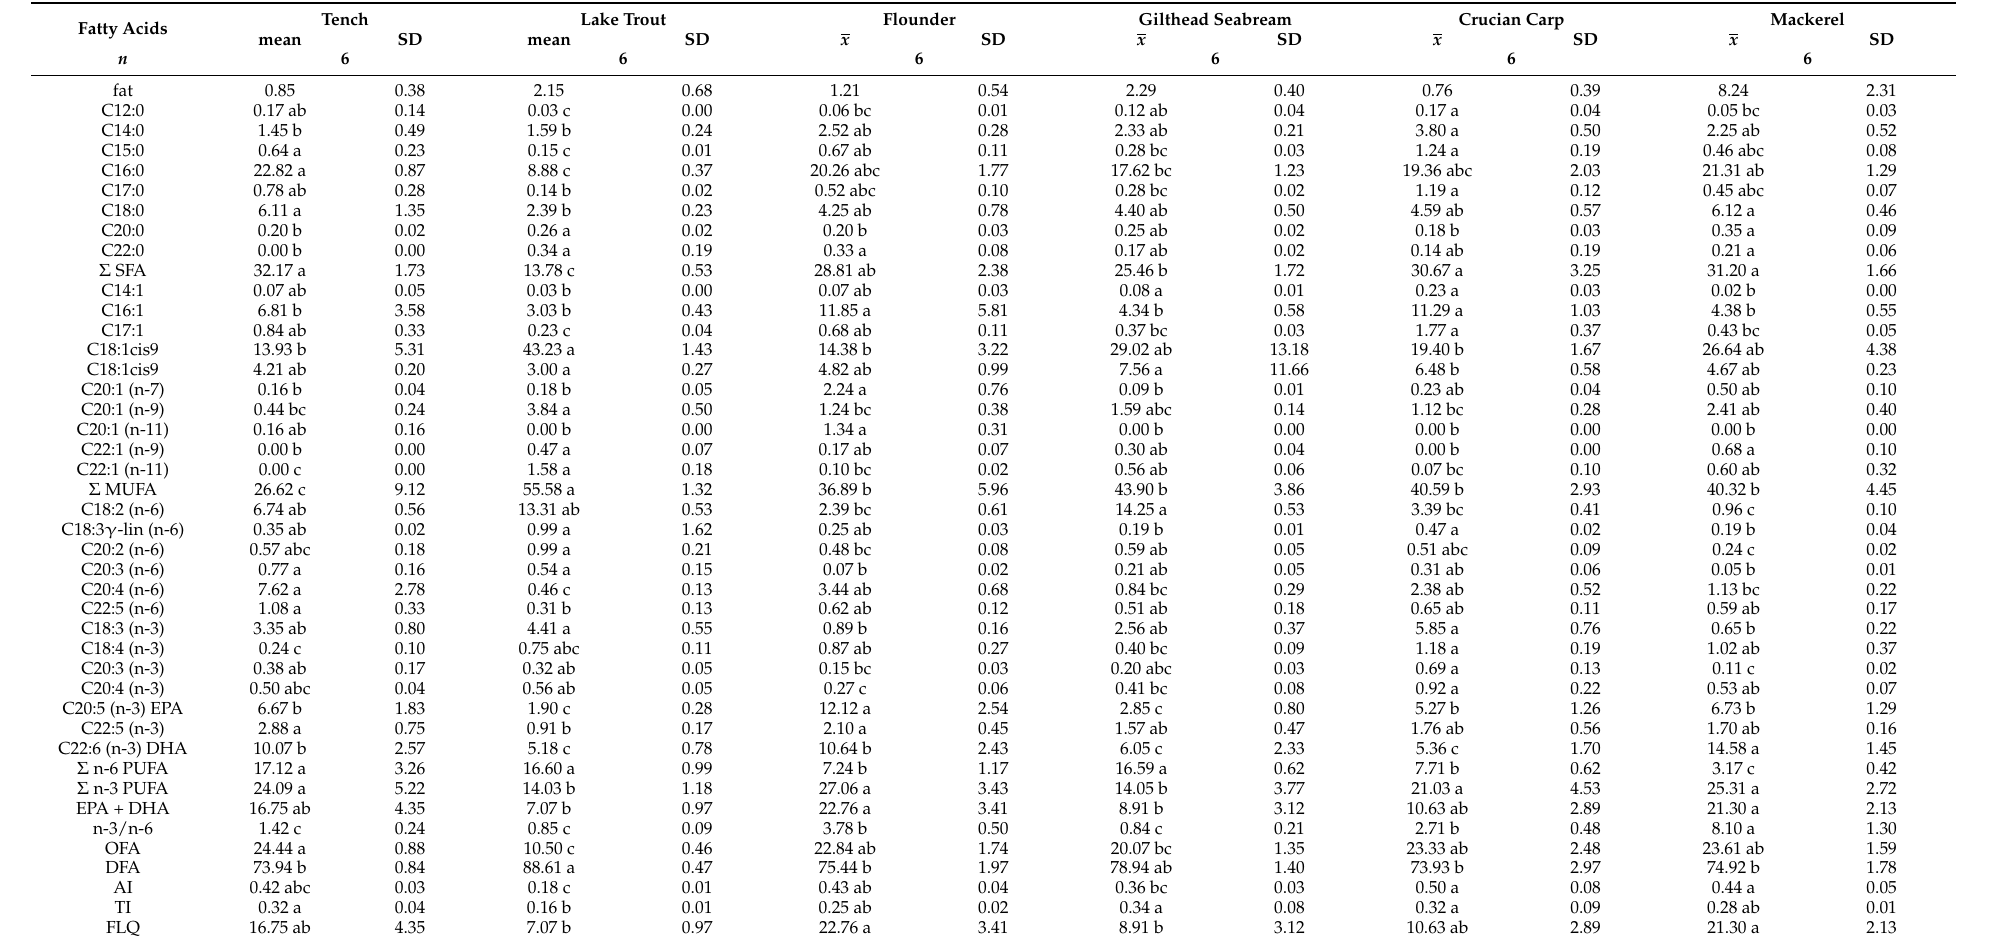
Table 2. Lipid content (%) and fatty acid composition (% of total fatty acids) in muscles of different fish